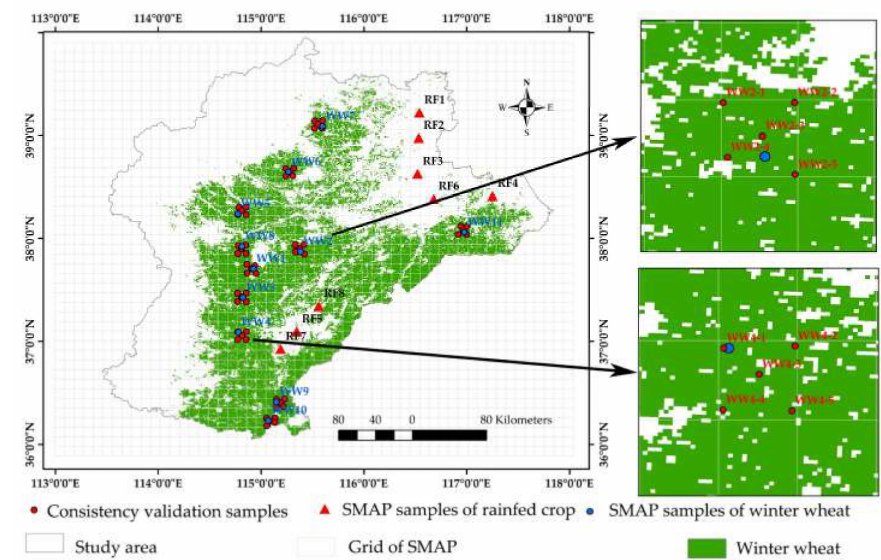
Figure 4. Sample maps. Red triangles and blue points are used to extract the SMAP SM time series signals from di ff erent crops; red points are used to extract the winter wheat NDVI time series signal and then compare the consistency of winter wheat growth covered by one SMAP